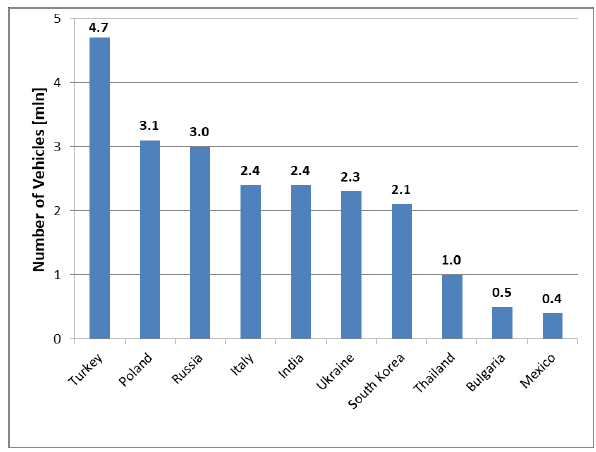
Figure 1: Countries with the largest number of LPG-powered vehicles in 2018 (mln. units.) [3].